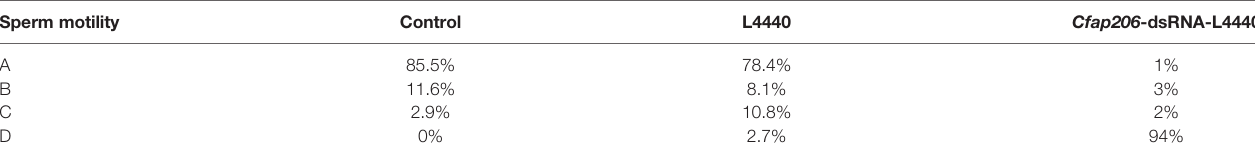
TABLE 6 | Sperm motility after feeding Cfap206 -dsRNA. Sperm motility